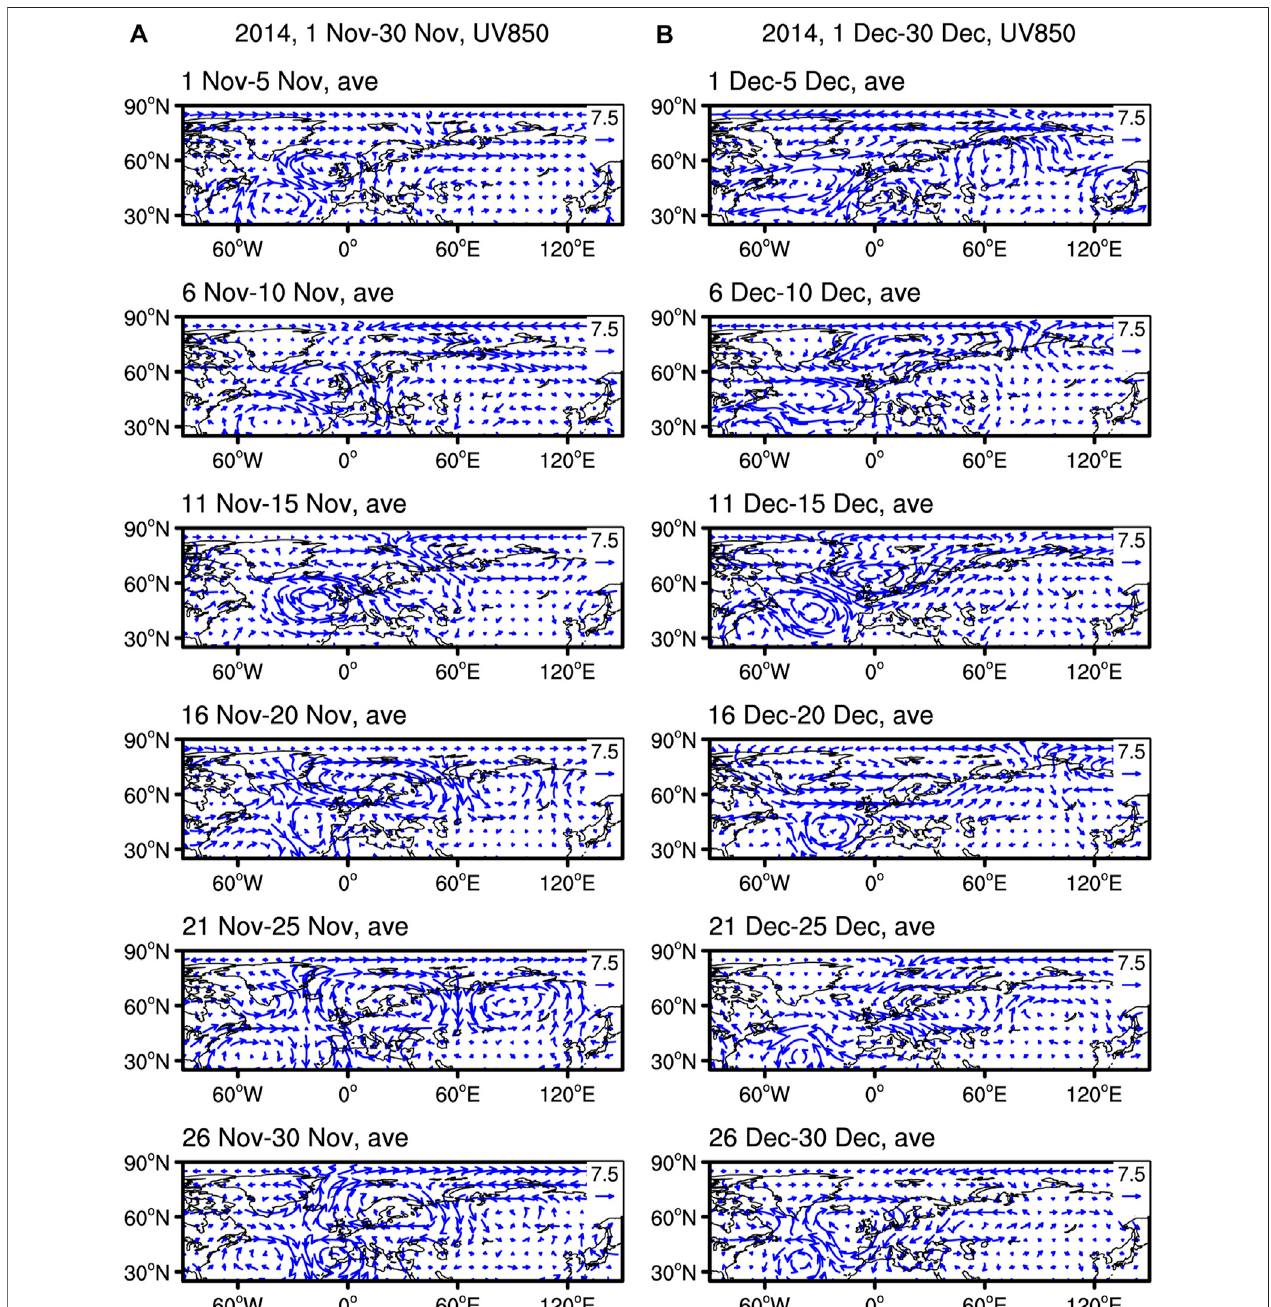
FIGURE 4 | Anomalies of horizontal wind at 850 hPa (unit: m s − 1 ) for each pentad in (A) November and (B) December 2014.